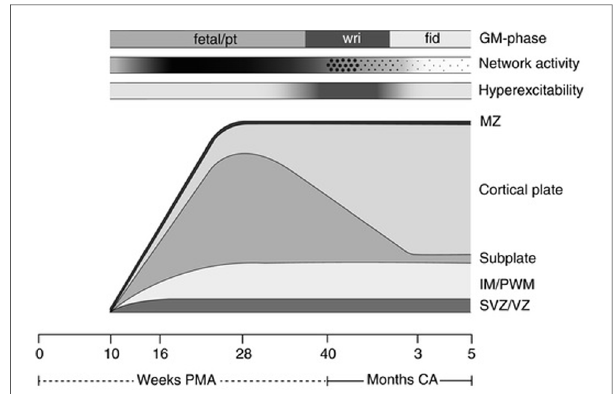
FIGURE 10 Schematic presentation of the processes underlying the subplate and cortical plate modulation hypothesis (5). The bottom line denotes age, fi rst in weeks PMA, after term (40 weeks) in months (corrected age). Above the age line the developmental changes in the human cortex are depicted. SVZ/VZ represents the subventricular and ventricular zones where the neurons and glial cells are generated; IM/PWM denotes the intermediate zone that gradually develops into the periventricular white matter; MZ is the marginal zone. The following three timelines represent from bottom to top: the hyperexcitability of the nervous system, in which the intensity of the grey shading represents the degree of hyperexcitability; the cortical network activity that emerges across the brain from 9 to 10 weeks PMA, this gradually increases (indicated by increasing shading) to be full-blown present (in the subplate) at mid-fetal age, before moving from global and widespread activity to local and limited activity to local and limited activity ( “ sparsi fi cation ” , indicated by the diminution of the dots); on top the developmental changes in general movements. GM, general movements; PMA, postmenstrual age; CA, corrected age; pt,